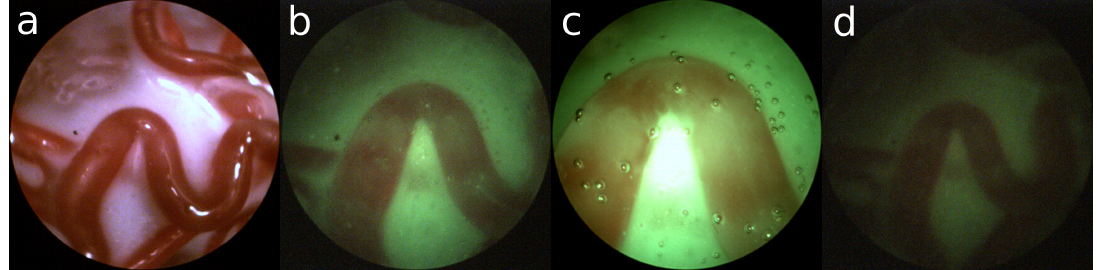
Figure 2. Ex-vivo: ( a ) sufficient structure; In-vivo: ( b ) nominal; ( c ) close and bright; ( d ) far and